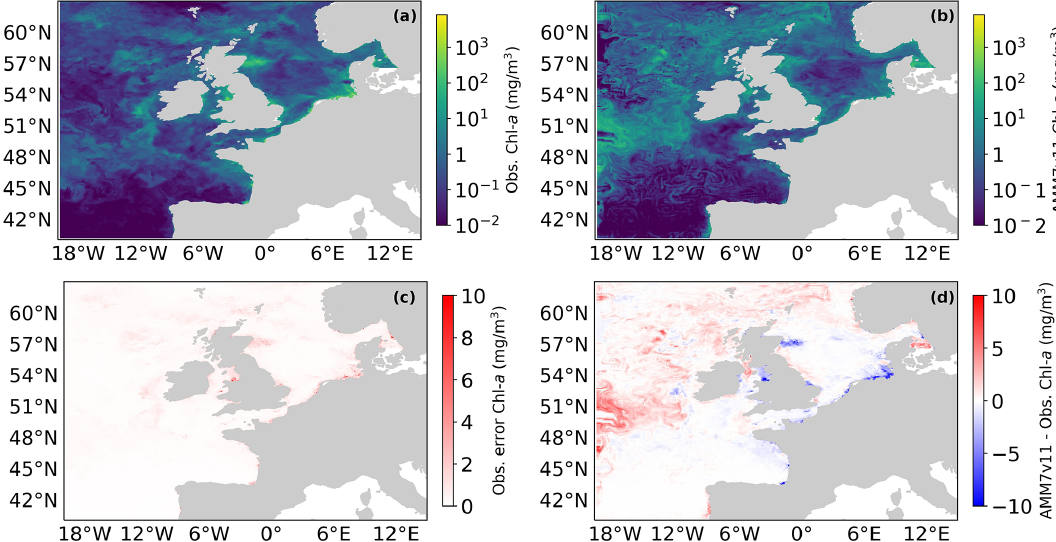
Figure 1. (a) Daily mean L4 multi-sensor observations regridded on the 7km resolution model grid and (c) AMM7v11 Chl a for 1 June 2019. (c) Error estimates on the multi-sensor L4 Chl a and (d) difference between AMM7v11 and the L4